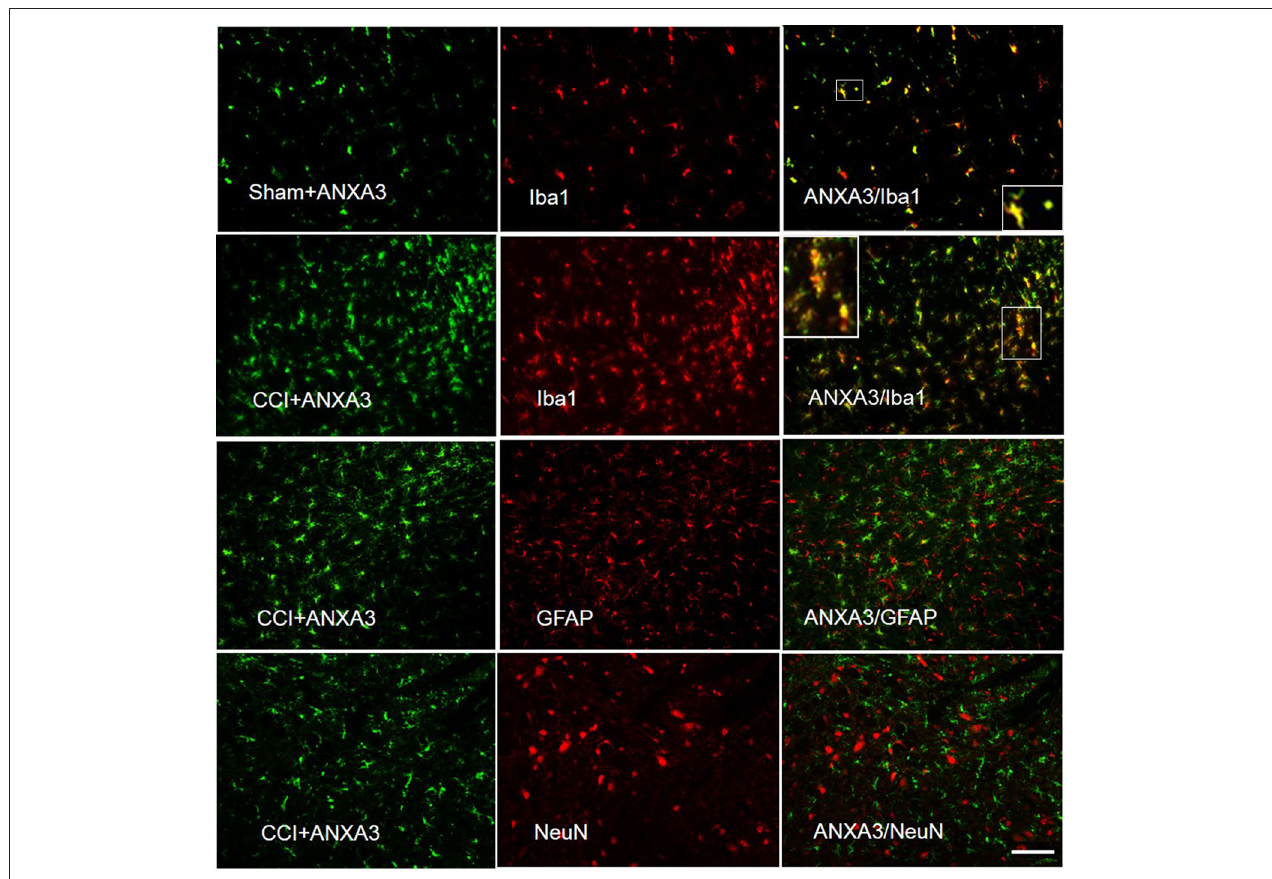
FIGURE 4 | Cell specific localization of Annexin A3 in the spinal cord of sham treated or CCI rats as assessed by immunofluorescence staining of the spinal cord for Annexin A3 (green), neurons using NeuN antibody (red), astrocytes using GFAP antibody (red), and microglia using Iba1 antibody (red). ANXA3 was co-expressed with the microglia in the lumber spinal cord. Scale bar = 50 µ